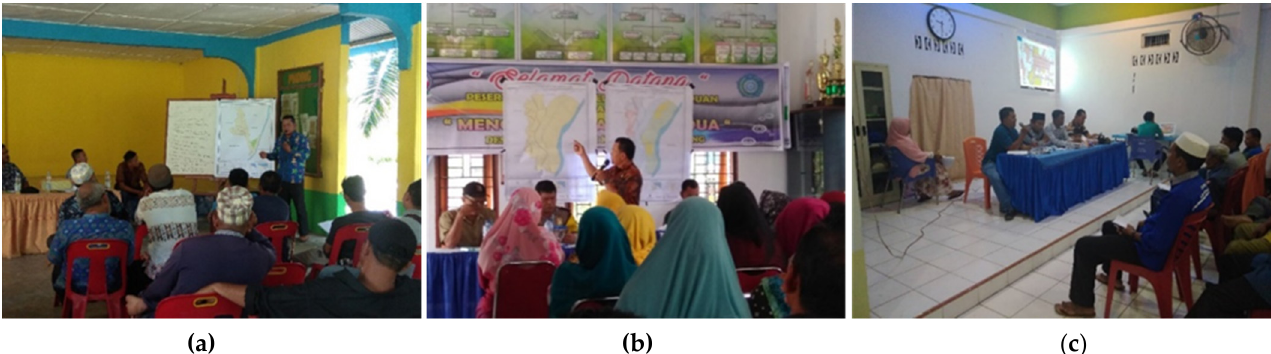
Figure 4. The village map was used at the Musrenbang: ( a ) Denai Lama, ( b ) Kramat Gajah, and ( c ) Kolam (source: first author).